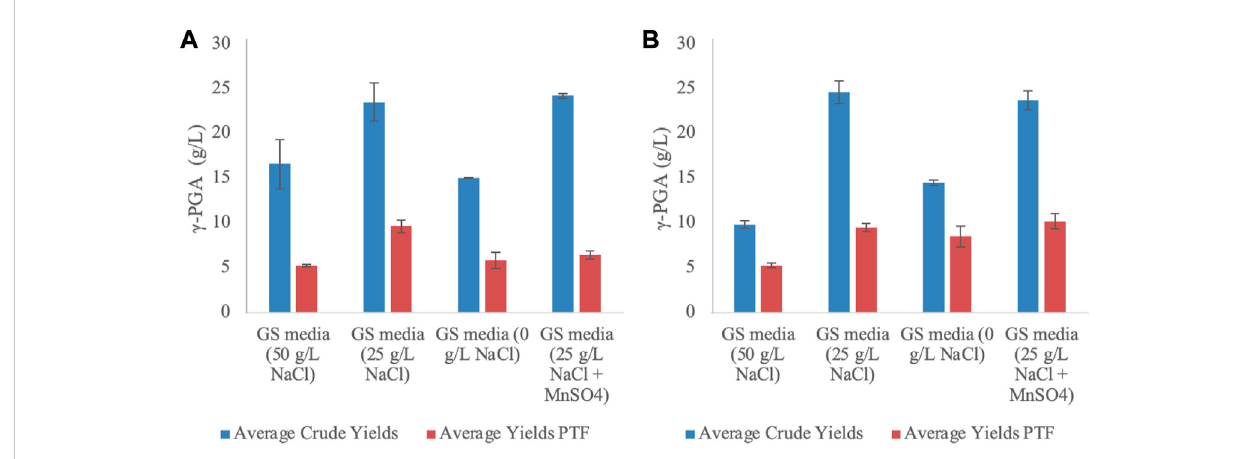
FIGURE 9 Average yields of γ -PGA (crude and PTF) obtained from standard cultivation media at varying NaCl concentrations in 4L fermenter (A) and 250 mL shake fl ask (B) . Error bars indicate standard deviation (n = 3).